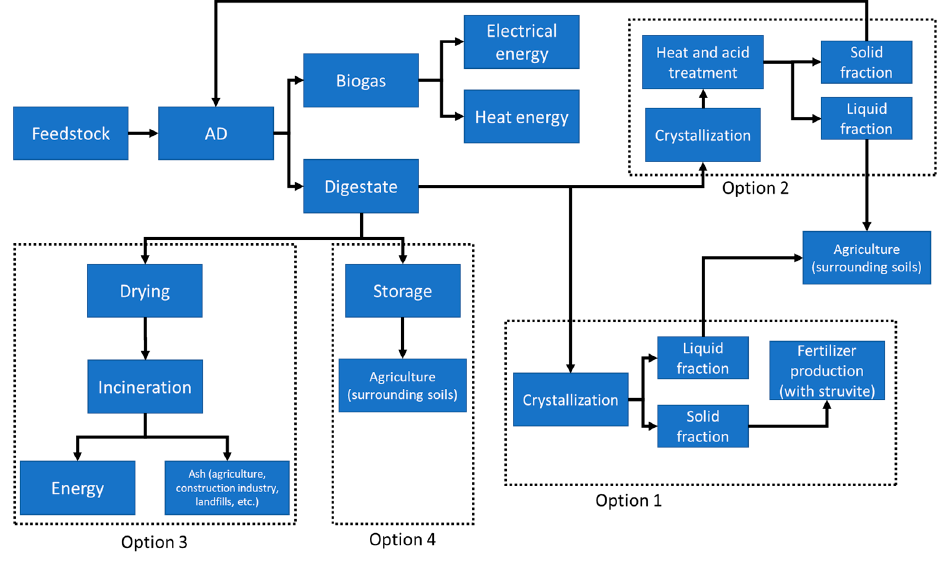
Figure 2. Flow chart for the digestate treatment options within the biogas facility scope.